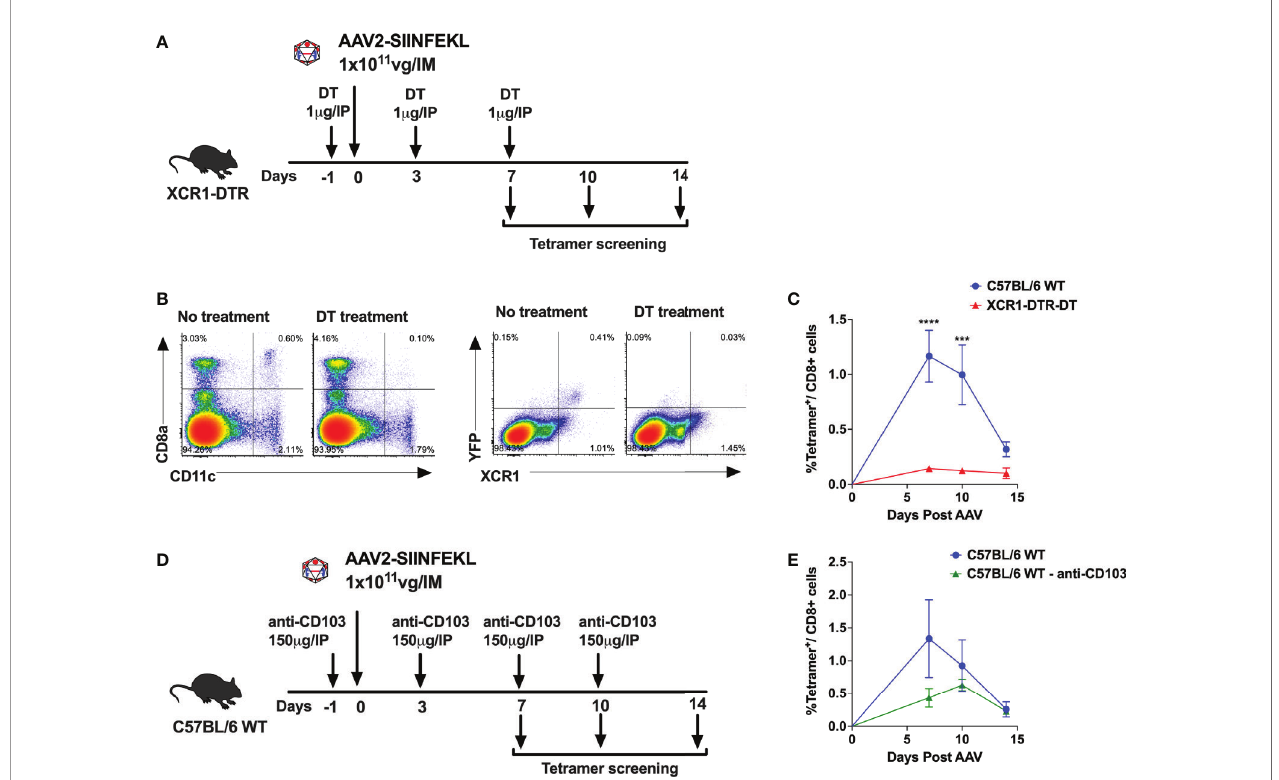
FIGURE 1 | XCR1 + DCs required for cross-priming of capsid speci fi c CD8 + T cells. (A) Experimental timeline showing treatment of XCR1 +/DTRvenus mice with DT to ablate XCR1 + DCs. (B) Representative fl ow cytometry plots showing CD8 a + CD11c hi DCs and XCR1 + YFP + DCs ( “ venus ” reporter) from DT treated and untreated mice. (C) Anti-capsid CD8 + T cell response reported as percent tetramer + CD8 + T cells at 7-, 10- and 14-day time points. (D) Experimental timeline showing treatment of C57BL/6 WT mice with anti-CD103 antibody to neutralize CD103 + DCs. (E) Percentage of tetramer + CD8 + T cells over time in anti-CD103 antibody treated and untreated mice. Data are average ± SEM of at least fi ve animals per group. Each circle represents an individual animal. Statistically signi fi cant differences are indicated. ***P < 0.001, ****P <